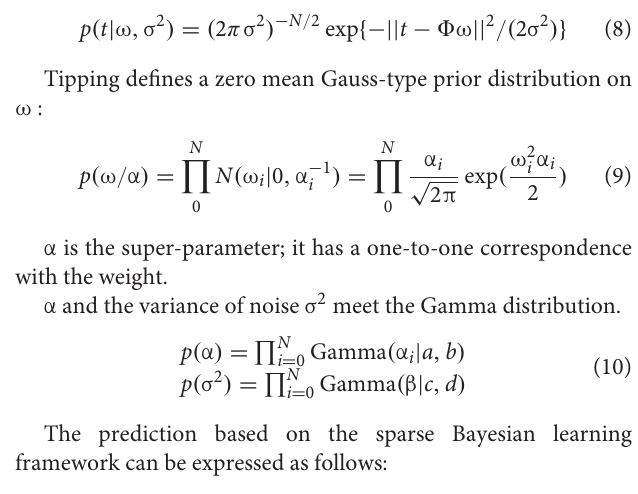
TABLE 1 | Encoding gene interaction network based on random